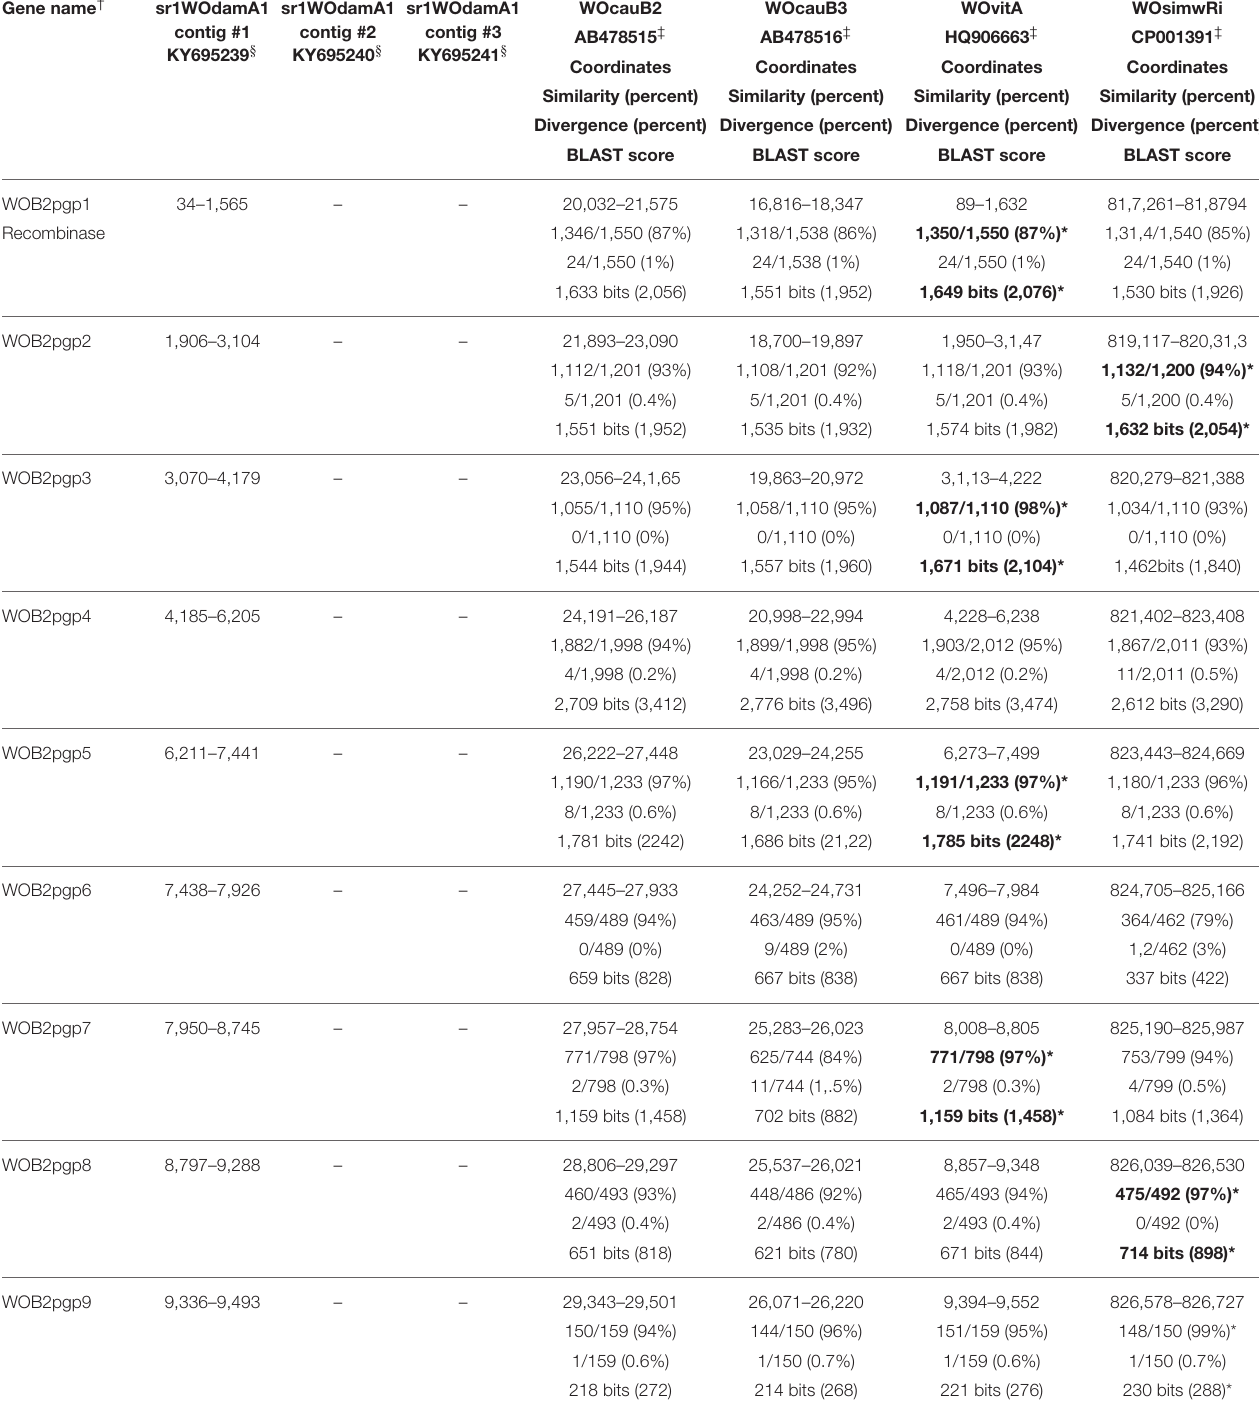
TABLE 2 | Conservation of gene content, synteny and sequence similarity in the sr1WO group Wolbachia phage, and gene-content inventory for the three sr1WOdamA1 Wolbachia phage contigs generated and characterized in this